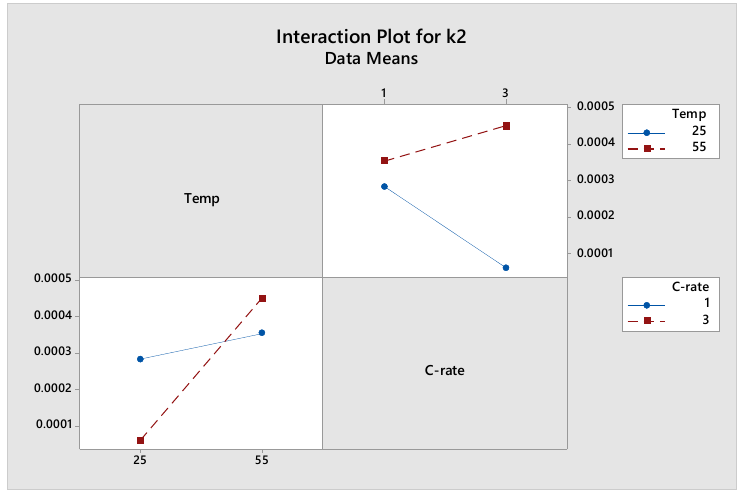
Figure 9. Interaction of current density and temperature in the k 2 value.